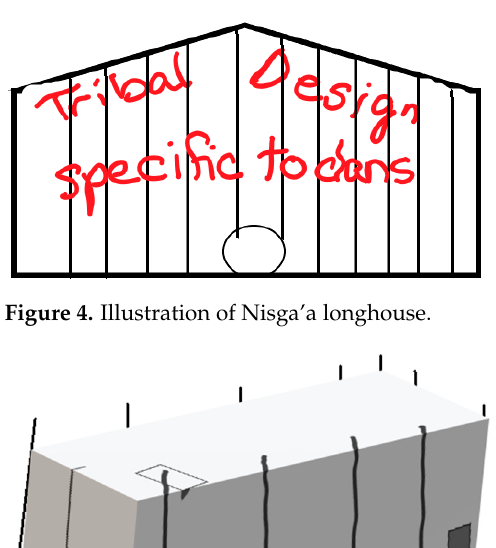
Figure 4. Illustration of Nisga’a longhouse.